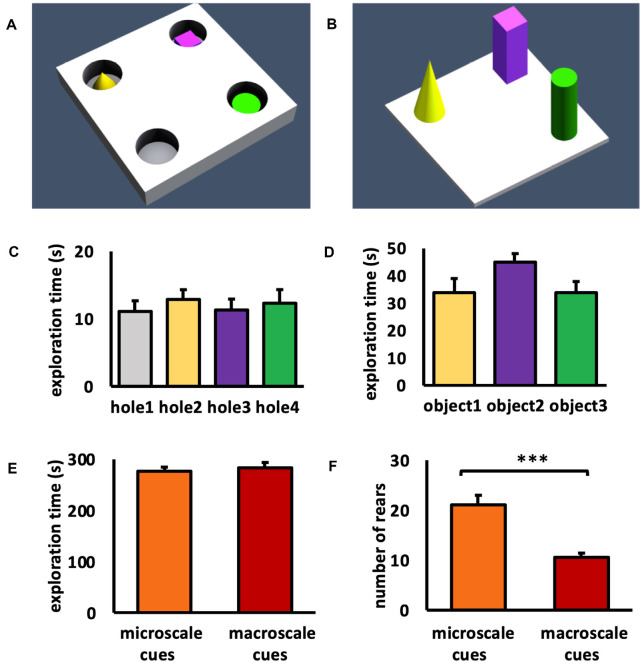
Schema of item-place configurations and object exploration behavior. (A,B) Animals either explored (A) three small novel objects (microscale cues) that were placed within three of four holes of a holeboard, or (B) three large novel objects (macroscale cues) that were placed on the floor of the chamber, for 5 min. (C) During microscale item-place exploration, the animals explored holes 2, 3, and 4 that contained microscale cues and hole 1 that did not contain an object, equally. ANOVA F(3,60) = 0.2514, p = 0.860057. (D) During macroscale item-place exploration, no preference was evident concerning the time spent exploring objects 1, 2, and 3. ANOVA F(2,36) = 1.9840, p = 0.152276. (E) No difference was evident between the total exploration times inside the chamber during microscale or macroscale item-place exposure. ANOVA F(1,27) = 0.000, p = 0.98764. (F) Animals that explored microscale item-place configurations engaged in a significantly higher number of rears compared to animals that were exposed to macroscale item-place configurations. ANOVA F(1,27) = 24.8538, p = 0.000032. (C–F) Mean ± SEM. (F) ANOVA: ***p < 0.001.